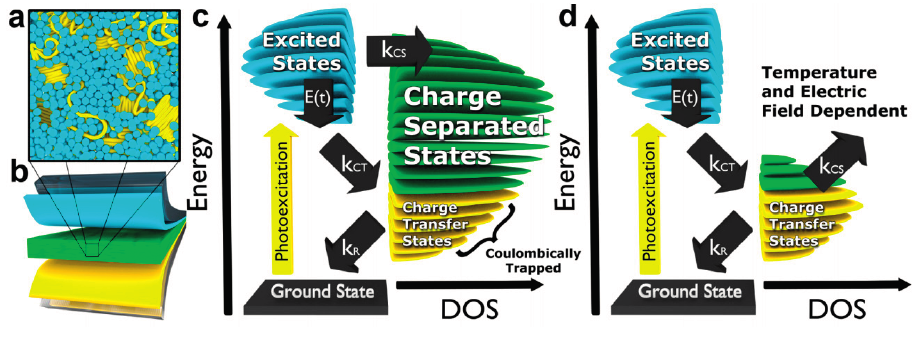
Figure 5. Fundamental charge generation processes, morphology, and device configuration in bulk-heterojunction organic photovoltaics: ( a ) Schematic depiction of the currently BM acceptors (blue spheres) and accepted bulk heterojunction microstructure with PC 60 polymer donors (gold strands) present with varying degrees of order and mixing; ( b ) Typical device configuration with the active layer (green) sandwiched between metallic and transparent electrodes. Interfacial layers (blue and gold) are chosen for selective extraction of electrons or holes. The states relevant to charge generation in ( c ) polymer:fullerene blends and ( d ) typical nonfullerene acceptor blends. Excited states (blue) predominantly occur in the donor phase with time-dependent localization and thermalization. In each case, the DOS accessible at the donor − acceptor heterojunction is depicted. In blends of fullerene ( c ), isoelectronic states resonant with the donor exciton facilitate charge generation directly. In nonfullerene blends ( d ), there is minimal accessibility to isoenergetic CS states, except through long-range tunneling or a Coulombically trapped intermediate. In each case, low-energy states are localized near the heterojunction and stabilized by the electron − hole refers to the rate of CT to unbound CS, k is the rate of CT to the Coulombic interaction. k CS CT is the rate of recombination. Cited from [64]. Copyright 2014, low-energy CT, and k R America Chemical